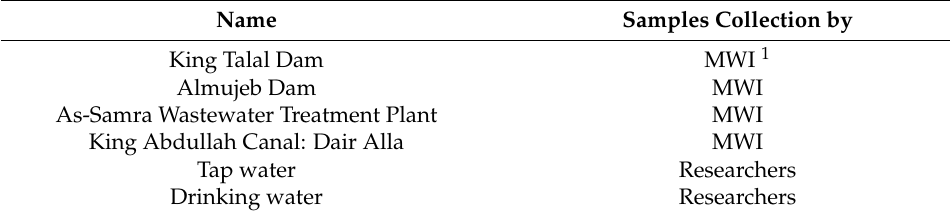
Figure 1. Summary of the Jordanian water system. ( A ) Surface water including dams, rivers, and streams. ( B ) Groundwater basins and their annual safe yield in millions of cubic meters [33].